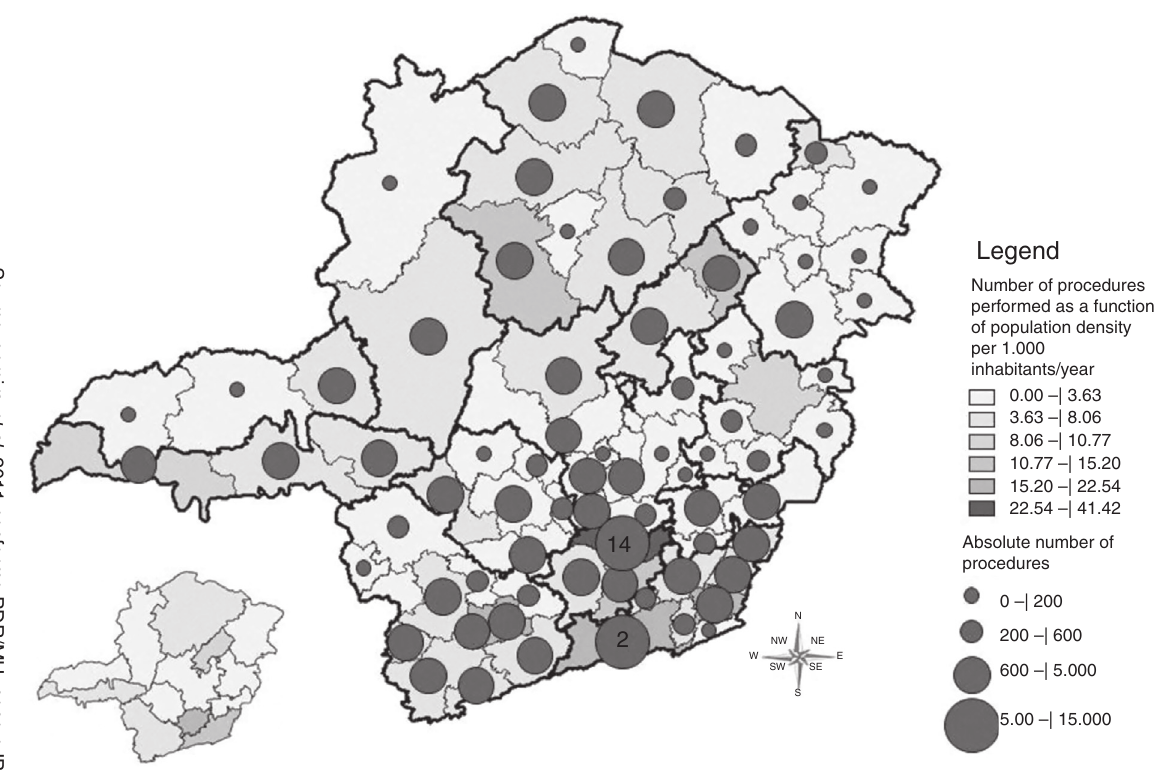
Spatial distribution according to micro- and macro-region of the ‘‘Follow-up’’ procedure for 1000 inhab./year and frequency. Minimum, maximum, mean, and standard deviation values as a function of the number of procedures performed considering the demographic density of 1000 inhabitants/year in the state of Minas Gerais.